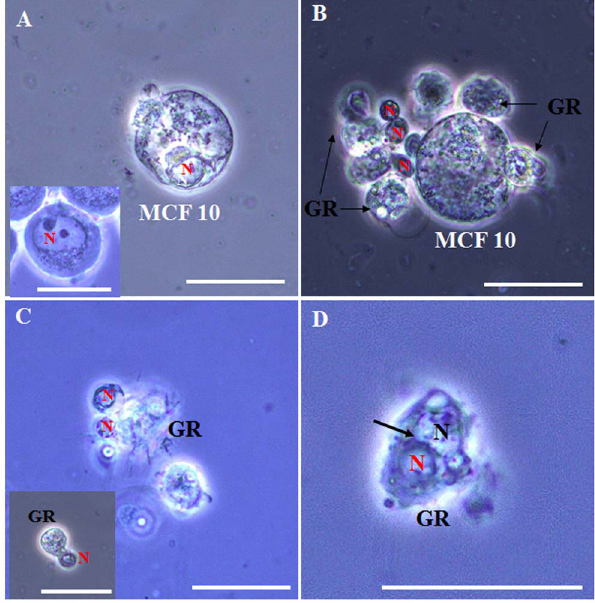
Figure 5. Granulocyte phagocytosis is dependent on foreign particle size. To examine the granulocyte’s phagocytic competence, human breast cells (MCF10; about two times bigger than granulocytes; average size , 43 m m, n=30) were injected into the hemocoel. (A) Autolysed MCF10 cells in the hemocoel; inset shows normal type of MCF10. (B) MCF10 nuclei indicated by red ‘‘N’’). Shown is encapsulation by granulocytes, which cluster around the MCF10 cell. (C) Exposed nuclei from MCF10 agglomerated together and were phagocytosed by granulocytes; inset, granulocyte amoeba-like structure capturing MCF10 nuclei. (D) MCF10 nuclei (indicated by red ‘‘N’’) were engulfed and phagocytosed by granulocytes, which showed classic structures of phagocytosis (cell-in-cell invasion; a crescent-shaped nuclei) indicated by black arrow. GR, granulocytes; N (red color), nuclei of MCF10 cells, N (black color), nuclei of granulocytes. Scale bar=20 m